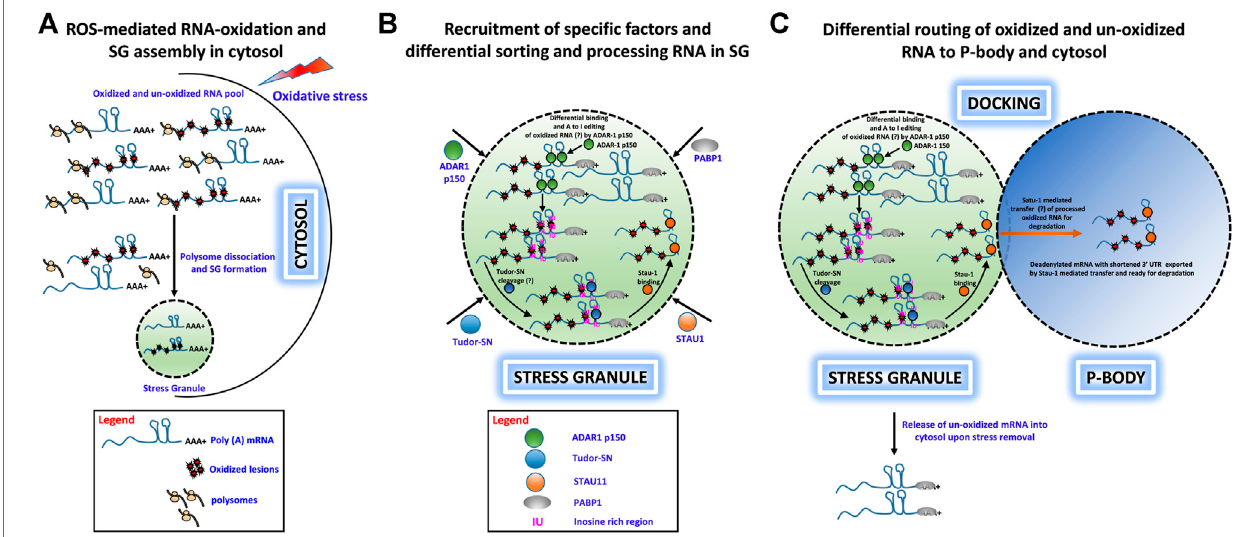
FIGURE1| HypotheticalroleofADAR1,Tudor-SN, andSTAU1instressgranule-mediated oxidizedRNAdecay. (A) ROS-mediated oxidation ofmRNAmolecules and stress granule formation under oxidative stress in the cytosol. Polysome-dissociated mRNA molecules with long 3 ′ UTRs along with several protein factors accumulate and form membrane-free stress granules. (B) Speci fi c recruitment of protein factors ADAR1, Tudor-SN, and STAU1 to stress granules. Under oxidative stress, ADAR1 and Tudor-SN translocate to stress granules speci fi cally, along with STAU1. ADAR1 may preferentially hyperedit (A – I) in ds 3 ′ UTR regions, and Tudor-SNcleaves mRNA at IU/oxidative lesion-richregions toproduce mRNA withshort 3 ′ UTRs. Theseshortened mRNAsdevoid ofapoly-A tail arebound bySTAU1 for subsequent processing. (C) Differential routing of oxidized and unoxidized mRNA from SG. Under oxidative stress, stress granules and P-bodies physically interact. During this docking process, STAU1 in SG binds to Tudor-SN processed, oxidized mRNA and transports it to P-bodies for degradation. Additionally, upon removal of oxidative stress, unoxidized and sequestered mRNA may be released from the stress granules for translational reinitiation.